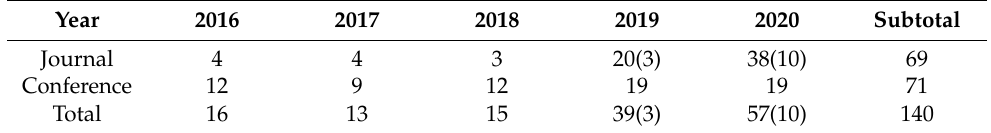
Table 1. The quantity of papers published each year in the past five years. The number in parentheses represents the quantity of papers published first